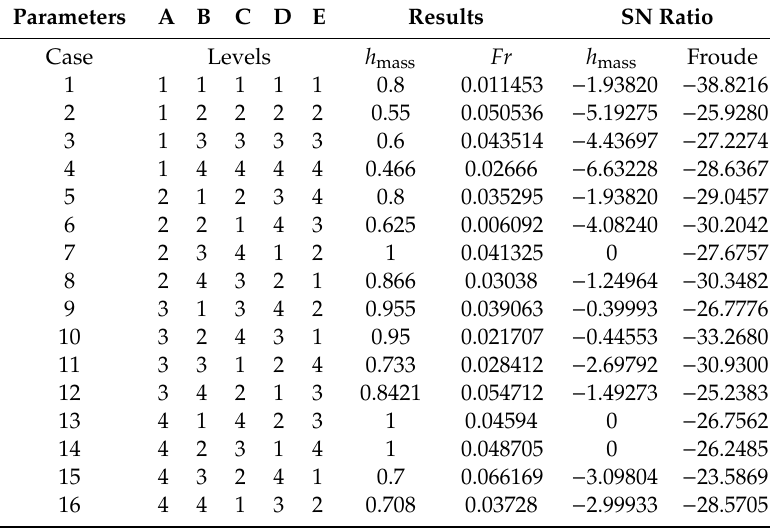
Table 4. h mass and Fr vary with their S / N ratios for the L 16 (4 5 ) orthogonal array.